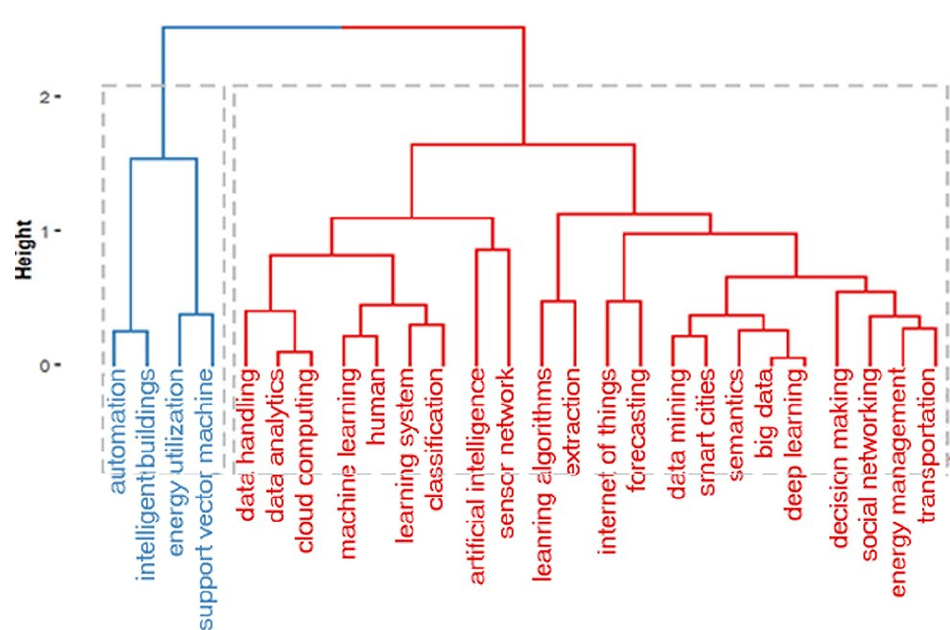
Figure 14. Thematic map. 4.6. Social Structure Co-citation analysis is a common analysis in bibliometrics. It employs citation counts as a measure of similarity between documents, authors, and journals [142]. As de Belis states, “Co-citation analysis rests on the premise that if two documents are cited by a third document, it is likely that some kind of structural relationship between them does exist, the strength of the relationship depending on how many times they are co-cited in a given corpus of literature. The more two documents are co-cited, the more likely it is that their